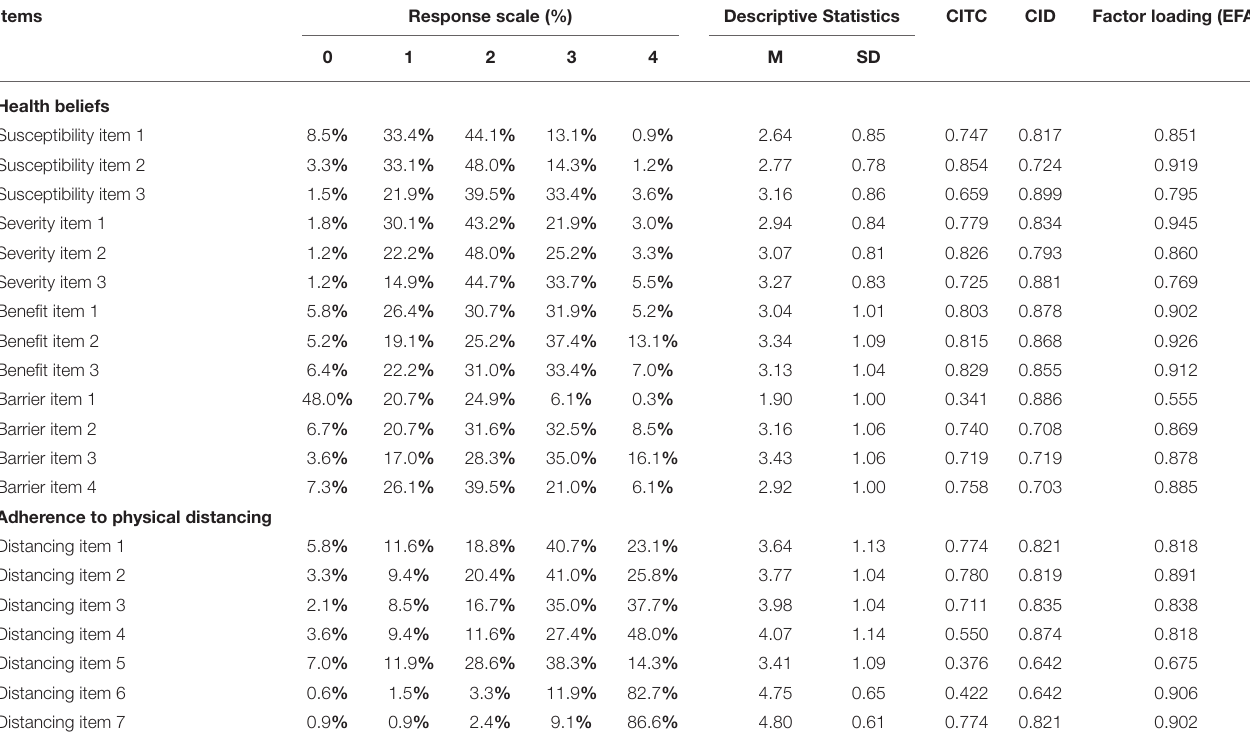
TABLE 2 | Factor structure of the Korean version of the questionnaires on adherence to physical distancing and health beliefs ( N = 329).